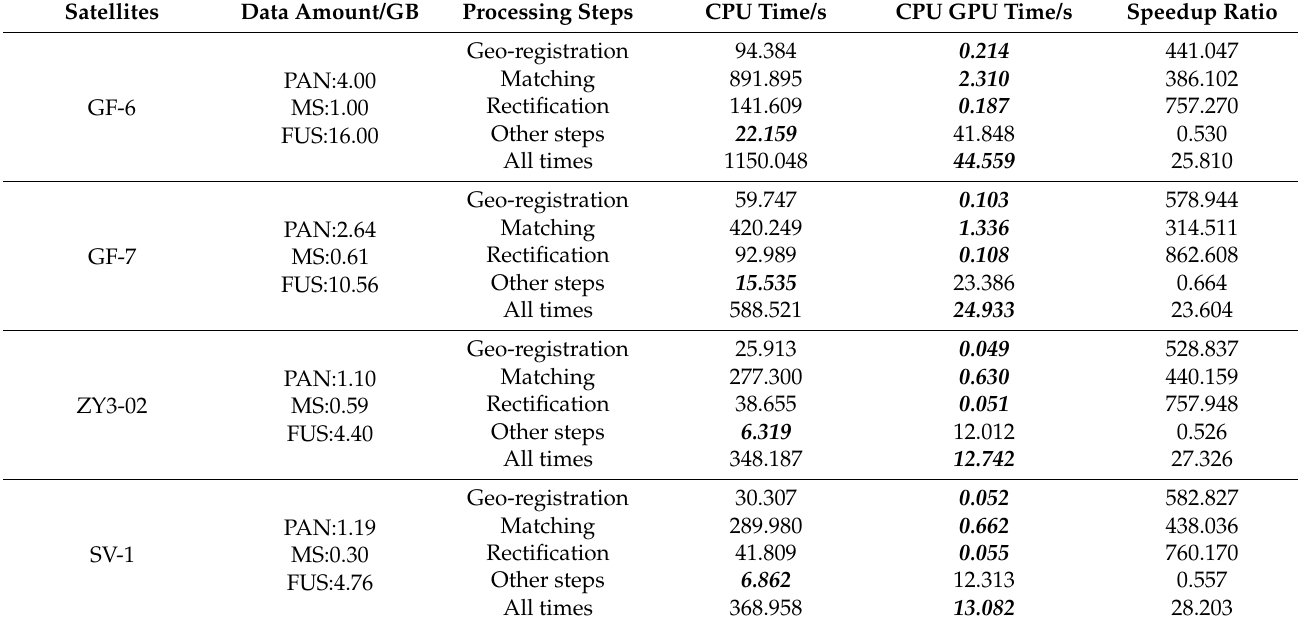
Figure 11. Time consumption with different amounts of FUS data. Table 4. Efficiency analysis.